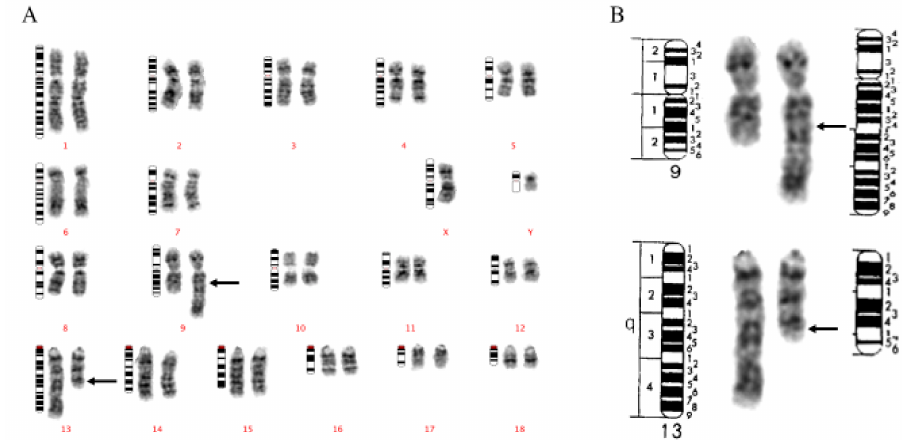
Figure 1. ( A ). GTG-banded karyotype of a Duroc boar carrying a t(9;13)(q24;q31). Derivative chro- mosomes are placed to the right. Arrows indicate presumptive breakpoints. ( B ). GTG-banded chromosomes of chromosomes 9, 13, and the derivative chromosomes formed by the reciprocal translocation event. The ideogram to the left of each chromosome pair indicates the normal chro- mosome structure. The ideogram to the right of each chromosome pair indicates the derivative chromosome structure. Arrows indicate presumptive breakpoints. Chromosome ideograms adapted from ref.